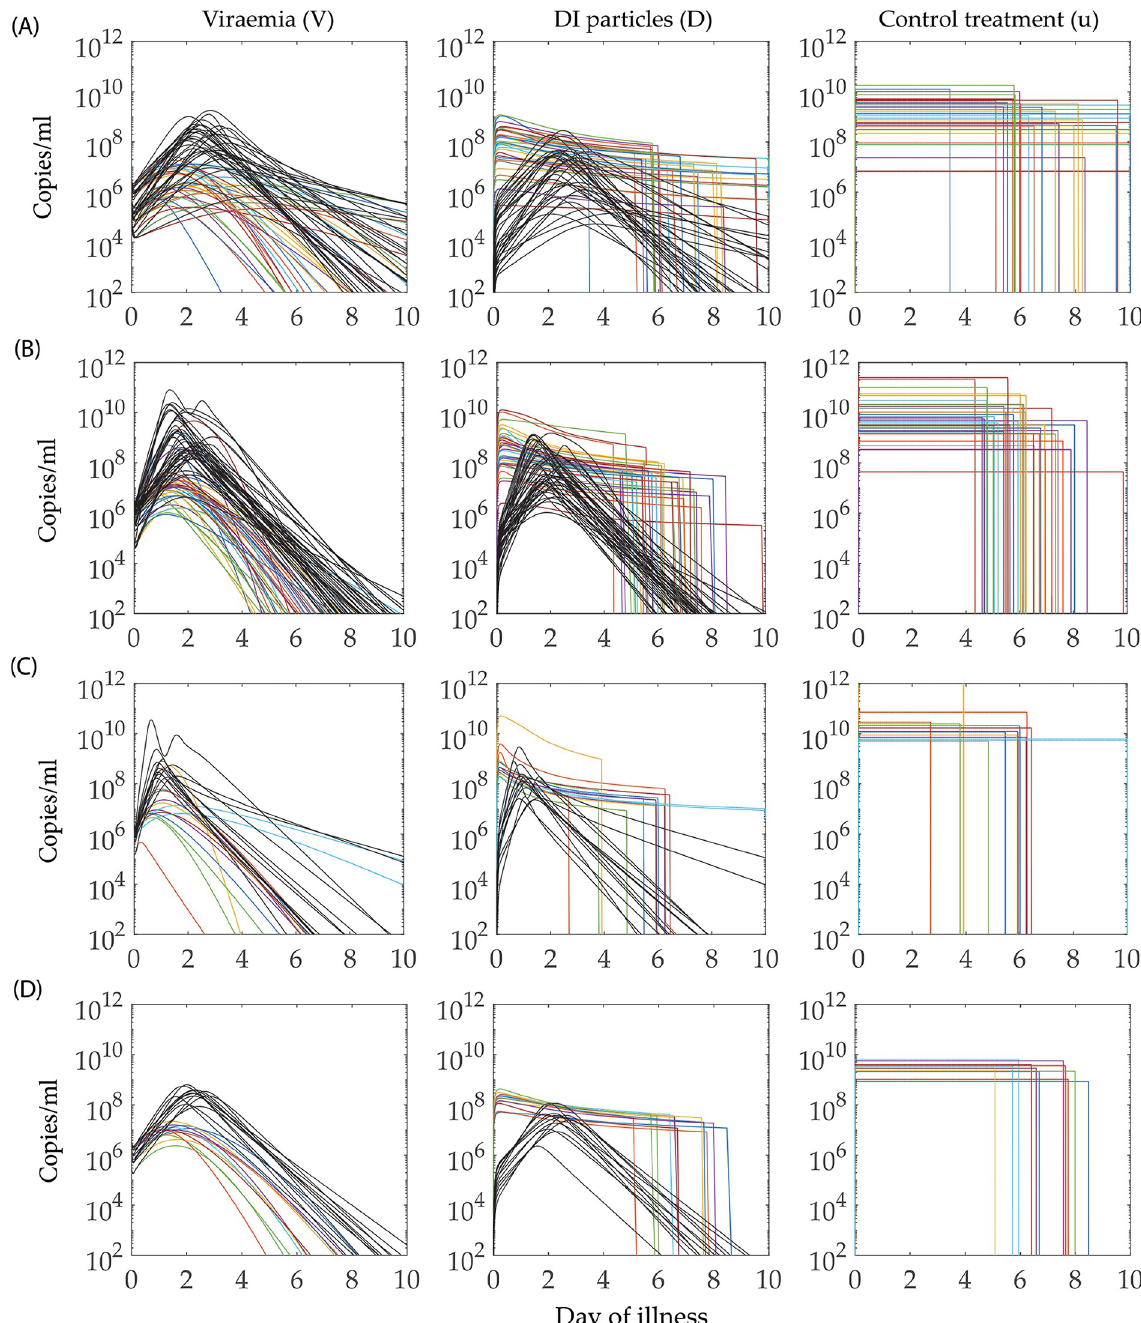
Fig 8. Effect of control treatment on viraemia and defective particles. Representatives of each serotype-specific infected POMs are considered for bang-bang control treatment with addition of excess DI particles as therapeutics. The black lines in the viraemia and DI particles columns are the untreated models from the POMs of (A) DENV-1, (B) DENV-2, (C) DENV-3 and (D) DENV-4, respectively. The coloured lines in the viraemia, DI particles and the control columns show the same models after the treatment with excess DI particles. The colours are used to observe a treated viraemia profile with corresponding treated profile of DI particles and control treatment. Each POMs appears with notable reduction in the viraemia profiles after successful addition of optimal doses of DI particles for optimal time periods.